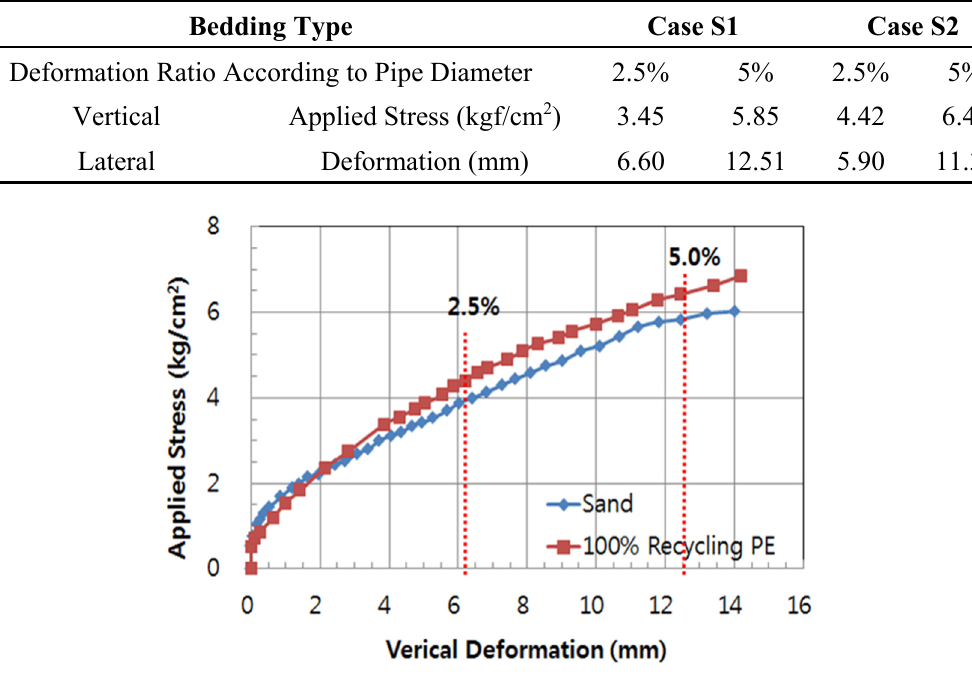
Figure 3. Vertical deformation of PE